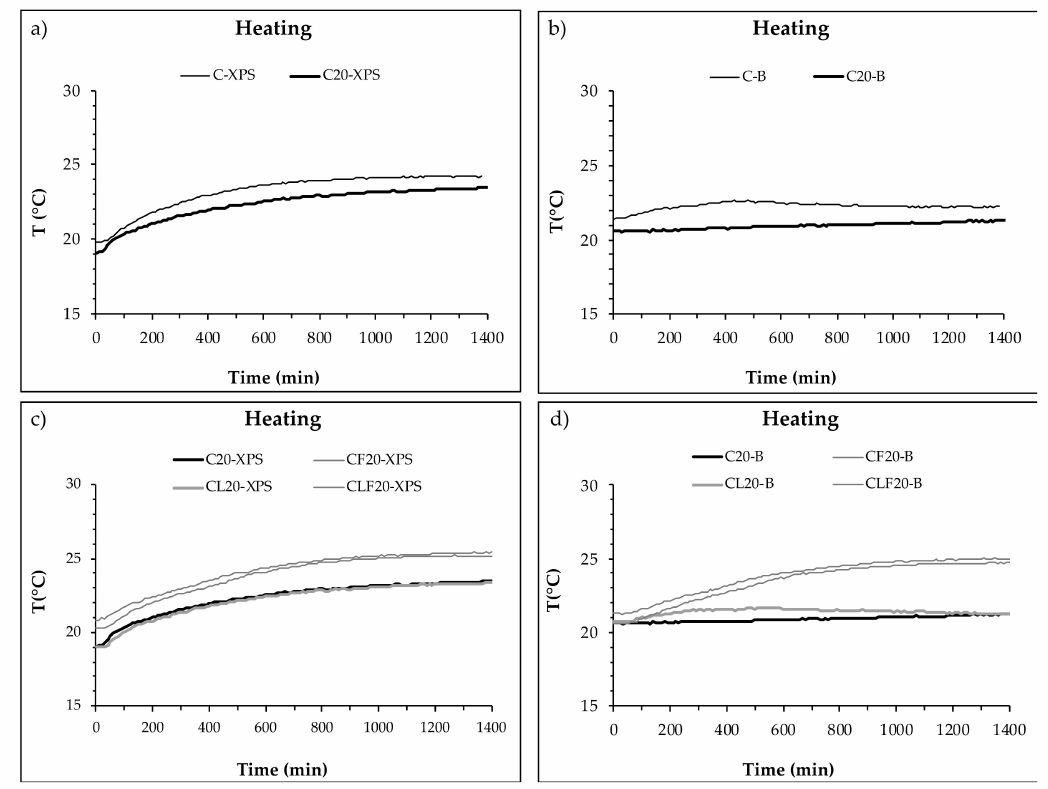
Figure 3. Temperature on both sides of the PCM cement-lime mortar layer during a heating cycle. ( a ) Inner side (XPS) of C and C 20 plates. ( b ) Outer side (B) of C and C 20 plates. ( c ) Inner side (XPS) of C 20 , CF 20 , CL 20 and CLF 20 plates. ( d ) Outer side (B) of C 20 , CF 20 , CL 20 and CLF 20